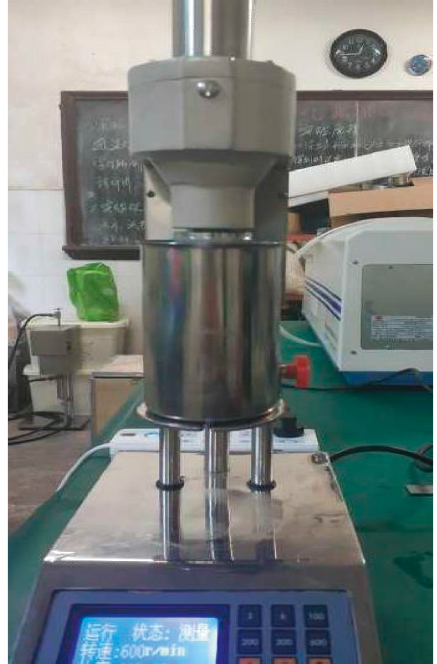
Figure 6: The six-speed rotating viscometer